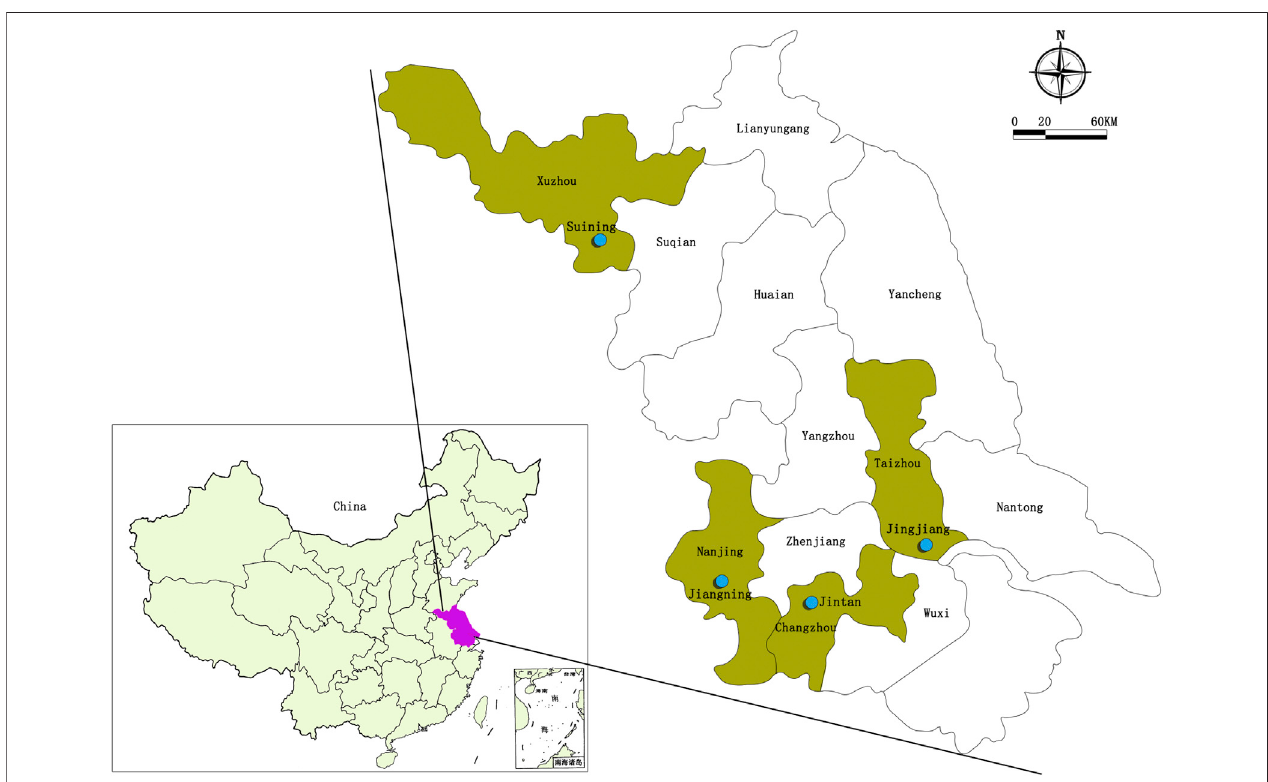
FIGURE 4 | Map of four pilot cities selected in this